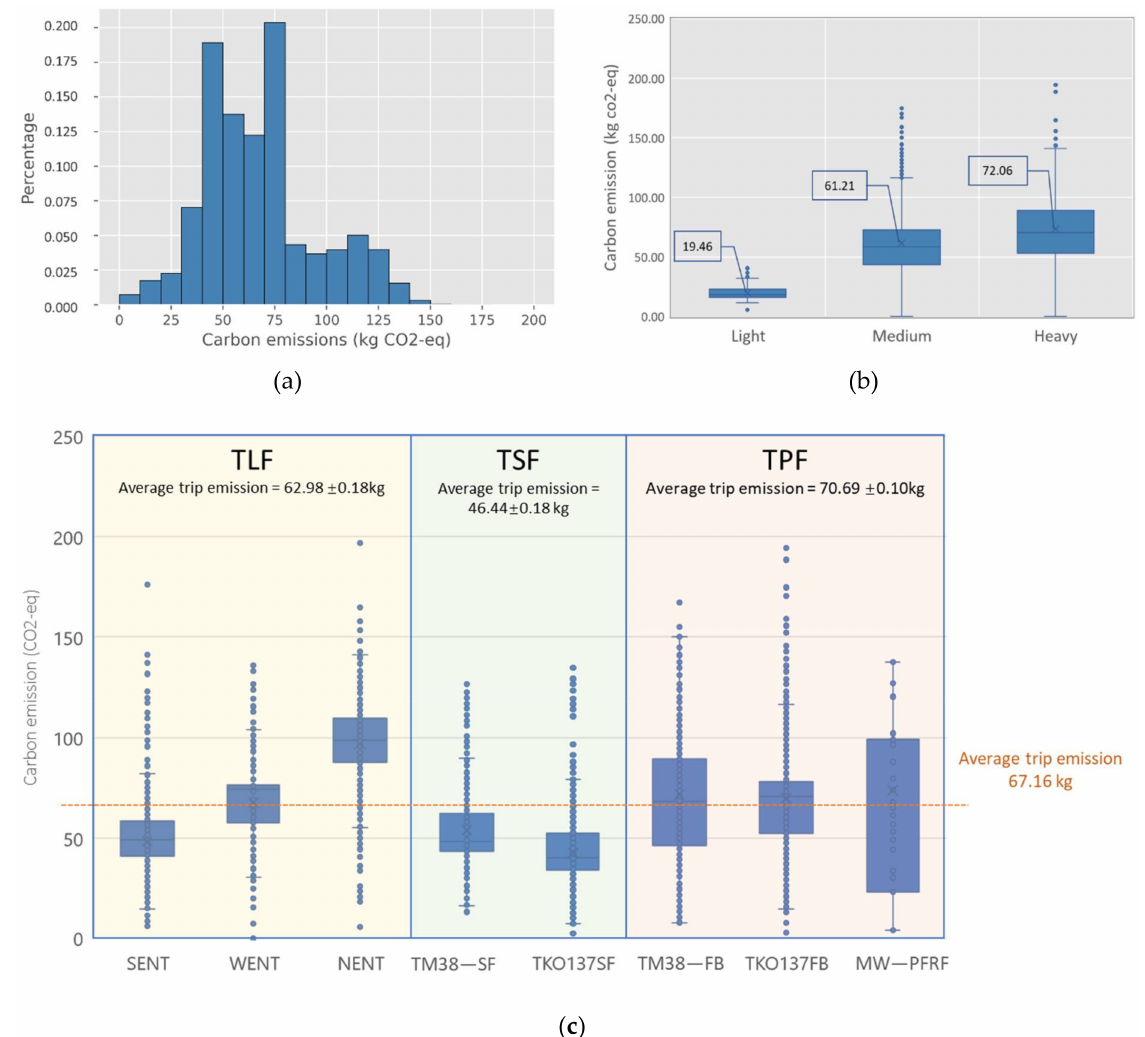
Figure 8. Carbon emission of CWHTs: ( a ) carbon emission histograms of CWHTs; ( b ) carbon emission distribution by vehicle types; ( c ) carbon emission distribution by freight trip types. Notes: Average trip emission in ( c ) is presented as mean ± SEM (standard error of the